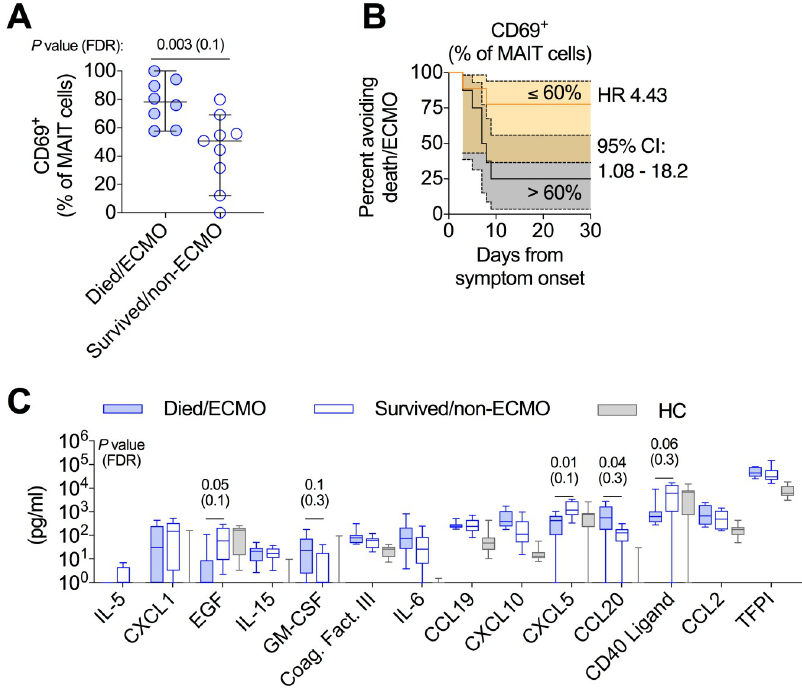
Fig 5. Activation of MAIT cells is associated with worse disease outcomes in critically ill influenza patients. Investigation of immunologic measures that were associated with mortality in the critically ill COVID-19 cohort, in a cohort of critically ill influenza patients. (A) MAIT cell CD69 expression on critically ill influenza patients who died or required ECMO versus those who did not. (B) Kaplan-Meier survival curve of disease outcome of critically ill influenza patients based on above or below median MAIT cell CD69 expression. (C) Examination of the concentration of 14 serum proteins in the critically ill influenza cohort and healthy controls, which were associated with mortality in the critically ill COVID-19 cohort (Fig 3). Dots represent individual patients (A), and median ± 95% CI are shown. (C) Median, IQR, and min to max are shown. (A and C) Mann-Whitney U-test with Benjamini-Hochberg FDR